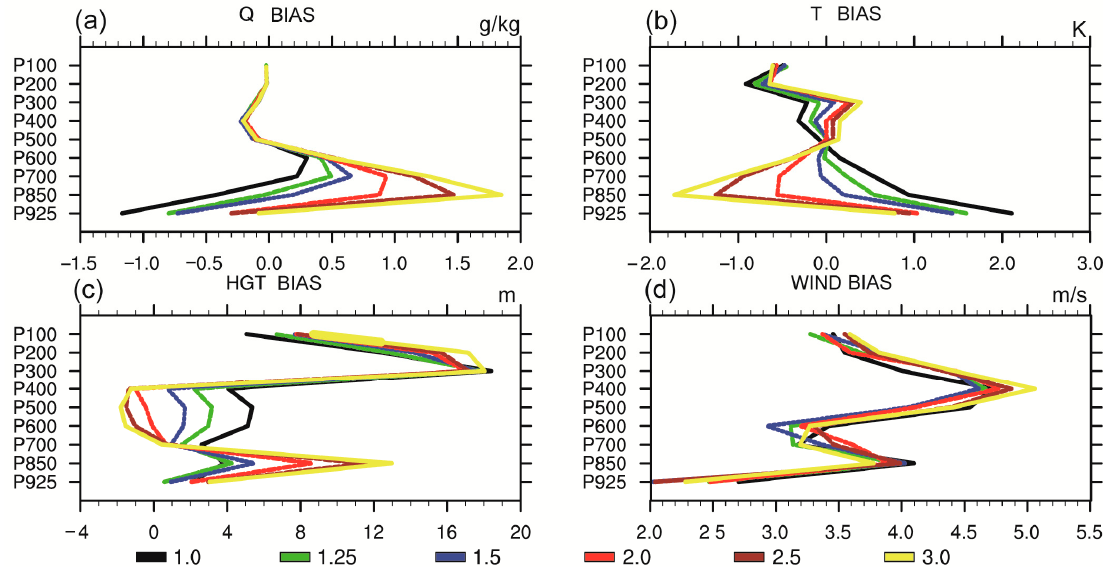
Figure 7. ( a ) Specific humidity; ( b ) potential temperature; ( c ) geopotential height (GPH) and ( d ) wind speed BIAS verified against observations of 14 meteorological sounding stations in Xinjiang under different soil moisture initial conditions. Note that the 1.0, 1.25, 1.5, 2.0, 2.5 and 3.0 multiples of NCEP GFS soil moisture are denoted as black, green, blue, red, brown and yellow lines, respectively. The figure shows the verification results for the upper air forecasts. The x -axis represents the BIAS, while the y -axis represents the values of different isobaric surfaces.